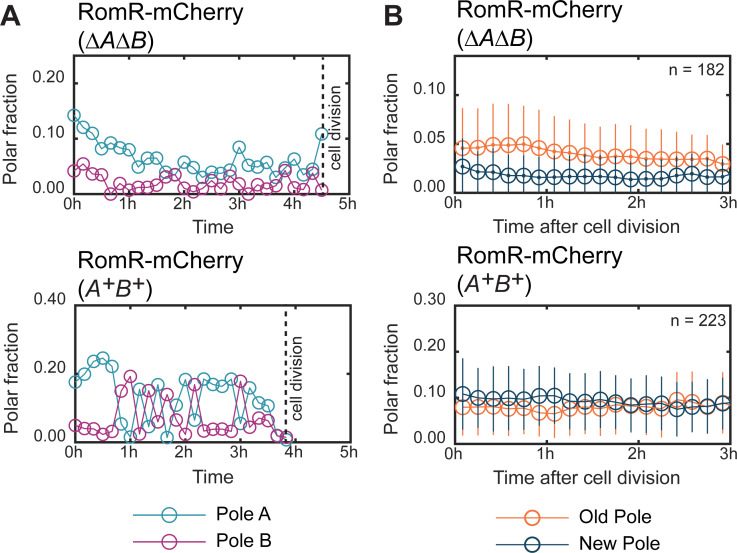
RomR polar localization is stably maintained and correlates with the old pole in the absence of MglA and MglB.A. Dynamics of RomR-mCherry polar fluorescence in representative single cells of the ΔmglA ΔmglB ΔaglQ (top) and ΔaglQ (bottom) strains. The ΔaglQ mutation was introduced to inactivate the gliding motility machinery and enable recordings of the same cells for several hrs. Pole A and B are defined as the pole with the highest and lowest fluorescence in the first frame, respectively. B. Fraction of RomR-mCherry fluorescence at the old (orange) and new (blue) cell pole as a function of time after cell division in the ΔmglA ΔmglB ΔaglQ (top) and ΔaglQ (bottom) strains. Plotted are the mean ± one standard deviation of all observed cells at each time point. n: number of cells observed immediately after division. Because cells divide at different time points during the recording period, the number of cells included at each time point varies; however, at least 40 cells were included per time point. In the absence and presence of MglA/MglB, RomR-mCherry localization was significantly biased (two-sided binomial test, p = 10−4 and p = 0.002, respectively) towards the old pole and new pole, respectively. The asymmetries in the two strains also differed significantly (χ2 test for independence, p = 10−6).